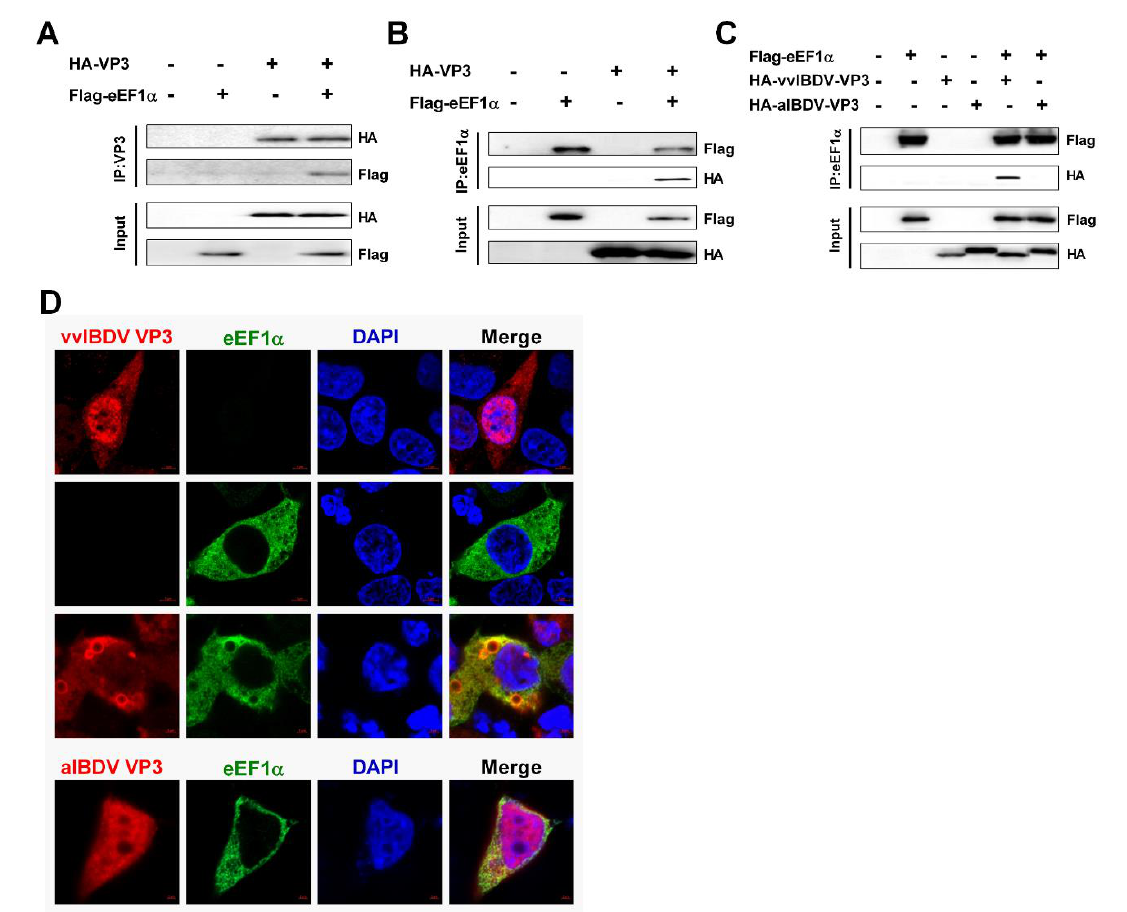
Figure 3. cheEF1α interacts with vvIBDV VP3, but not aIBDV. VP3 ( A ) 293T cells were transfected with HA-vvIBDV VP3 and Flag-cheEF1α expression plasmids. Cell lysates were prepared at 36 hours post transfection and immunoprecipitated with anti-HA antibody and immunoblotted with anti-Flag or anti-HA antibodies. ( B ) 293T cells were transfected as in (A). Cell lysates were prepared at 36 hours post transfection and immunoprecipitated with anti-Flag antibody and immunoblotted with anti-Flag or anti-HA antibodies. ( C ) 293T cells were transfected with HA-vvIBDV VP3 and Flag-cheEF1α or HA-aIBDV VP3 and Flag-cheEF1α expression plasmids. Cell lysates were prepared at 36 hours post transfection and immunoprecipitated with anti-Flag antibody and immunoblotted with anti-Flag or anti-HA antibodies. ( D ) 293T cells were transfected with HA-vvIBDV VP3 and/or Flag-cheEF1α for 36 hours and then fixed and processed for dual-immunostaining. Cell nuclei were counterstained with 4ʹ6-diamidino-2-phenylindole (DAPI) (blue). VP3 (red) and cheEF1α (green) proteins were visualized by labelling with anti-HA and/or anti-Flag antibodies, respectively, and were observed using confocal microscopy. Scale bars were marked down right corner. VP3 staining is shown in red, and cheEF1α staining is shown in green; merged images are shown with areas of co-localization in yellow. Each co-immunoprecipitation experiment was repeated three times.